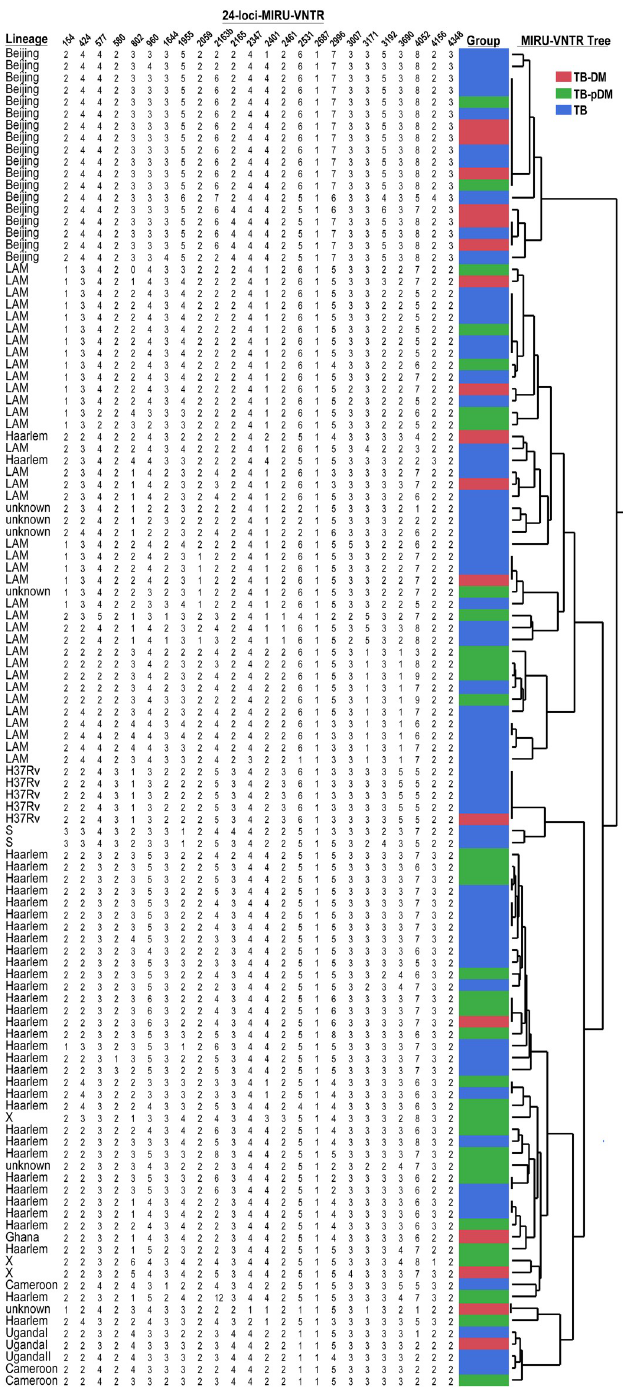
Fig 3. Cluster analysis of M . tuberculosis from clinical isolates of the study population. The MTB assignment and clustering analysis are based only on mycobacteria interspersed repetitive unit variable number tandem repeat analysis profiles among patients with tuberculosis and diabetes mellitus (TB-DM) (in red), patients with tuberculosis and prediabetes (TB-PDM) (in green) and patients with just TB alone (in blue). Some MTB isolates have shared clades and may be due to the presence of amplicons not determined by MIRU-VNTR and the most likely value assignment by JMP 13.0 software (SAS, Cary, NC, USA) has allowed limited discrimination; so WGS was necessary to confirm MTB